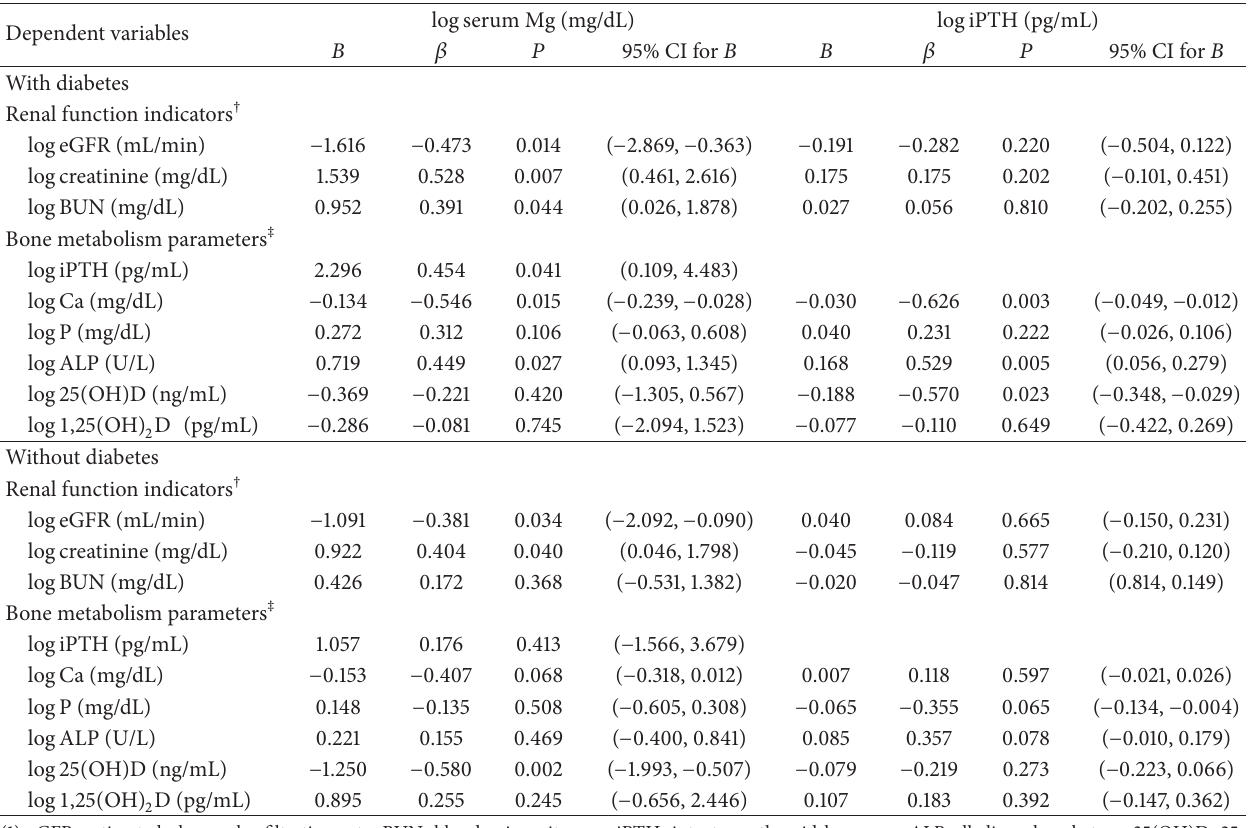
Table 2: Relationships between serum Mg with renal function and bone metabolism parameters in CKD patients with or without diabetes. Dependent variables